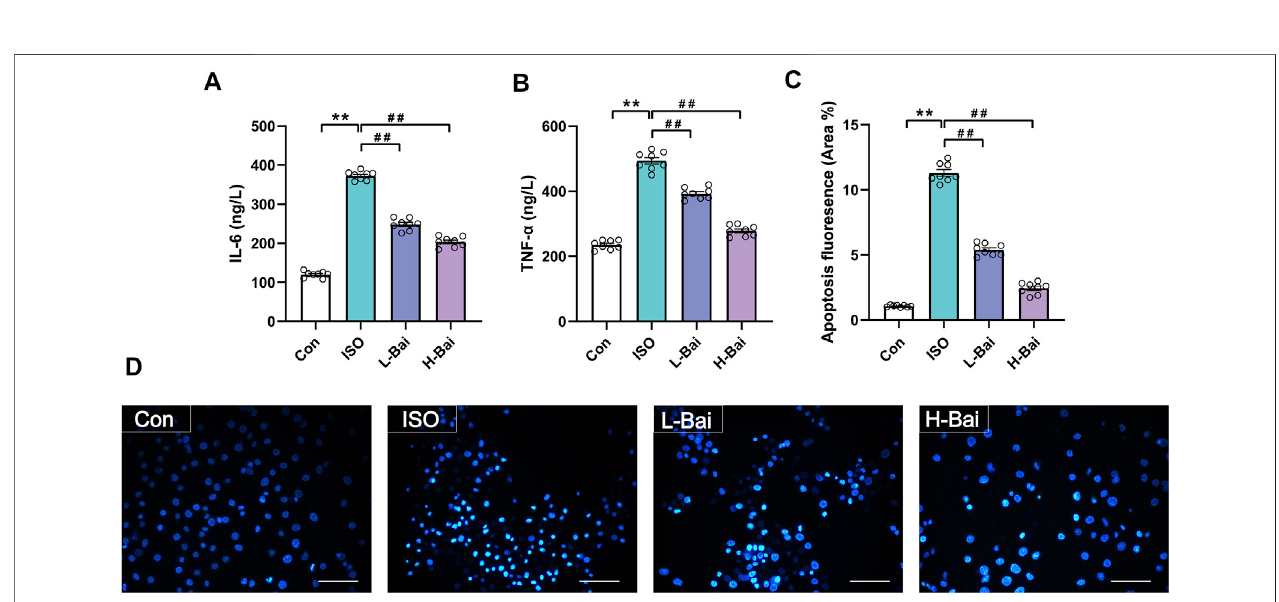
FIGURE 10 | (A,B) Effects of Bai on levels of IL-6 and TNF- α in H9c2 cells. (C,D) Effects of Bai on apoptosis of MI cardiomyocytes by Hochest 33258 staining. Apoptotic fl uorescence pictures from different groups; and the ratio diagram about fl uorescence intensity of apoptosis is exhibited. Values are presented as means ± S.E.M. p < 0.01 versus Con; p < 0.01 versus ISO group, n = 6.